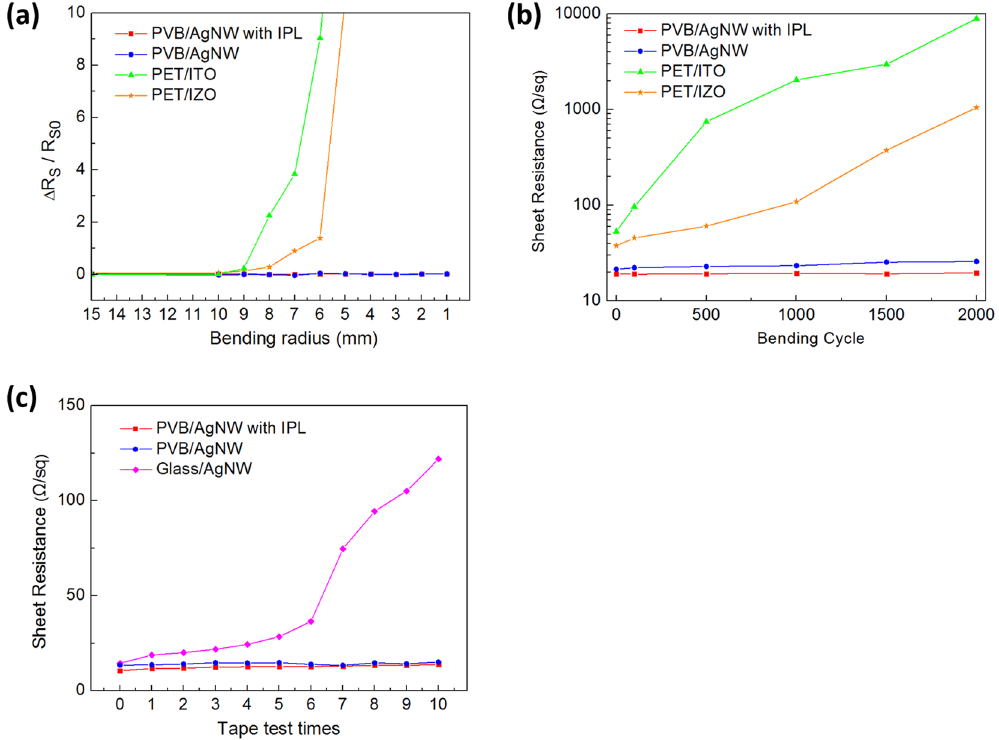
Figure 4. ( a ) Measured normalized sheet resistance variation ( Δ R s /R s0 = (R s (bent) − R s0 (unbent))/R s0 (unbent)) of PVB/AgNWs, ITO (t ITO = 130 nm), and IZO (t IZO = 200 nm) electrodes on a PET substrate (t PET = 200 µ m) as a function of bending radius. ( b ) Sheet resistance change of the PVB/AgNWs samples with and without IPL exposure, PET/IZO, and PET/ITO electrodes as a function of number of bending cycles. ( c ) Sheet resistance change of the PVB/AgNWs and Glass/AgNWs electrodes as a function of number of tape